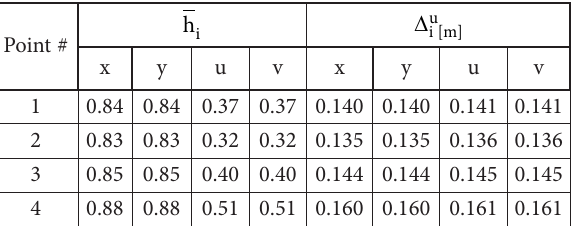
Table 2. The internal reliability